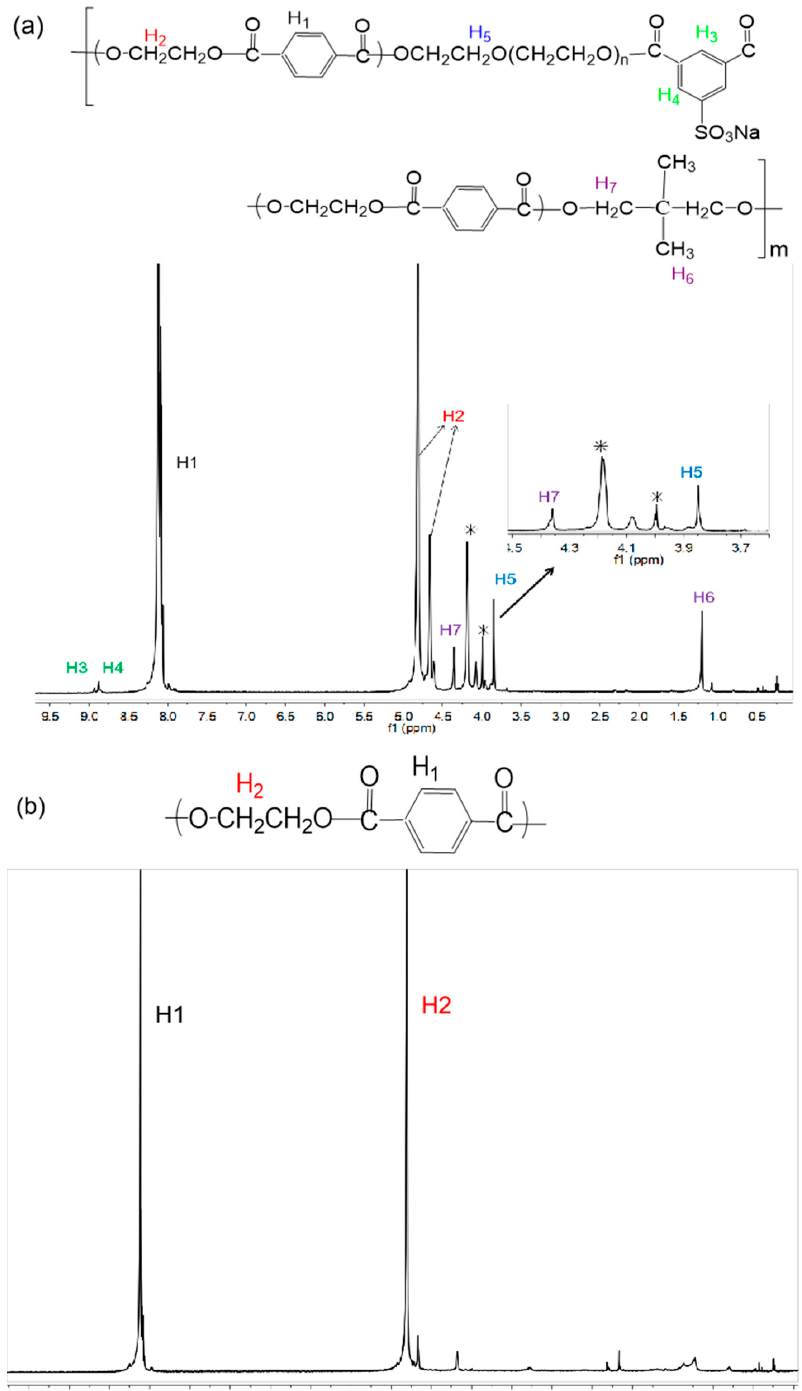
Figure 2. 1 H-NMR spectra of ( a ) ENCDP-0 and ( b ) PET-0.